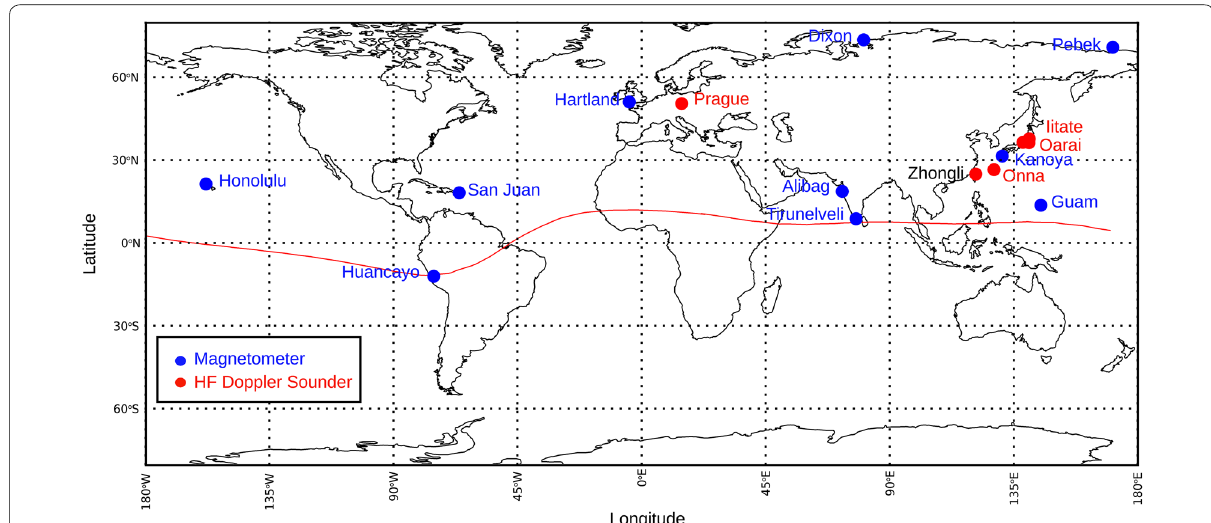
Fig. 1 Maps of the HF Doppler sounders in Japan, Czech Republic and Republic of China (red) and of magnetometers at high-equatorial latitudes (blue). The dip-equator is shown with the red curve. Details of the stations are listed in Table